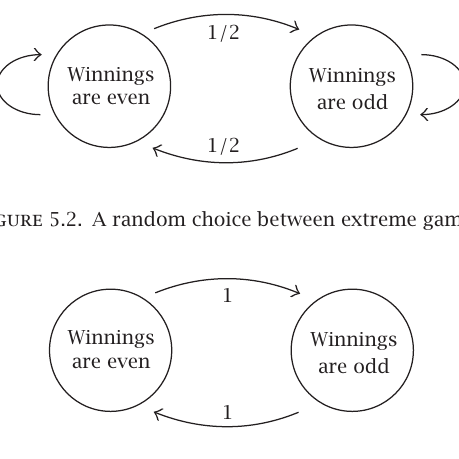
Figure 5.3 . The ultimate, nonprobabilistic Parrondo